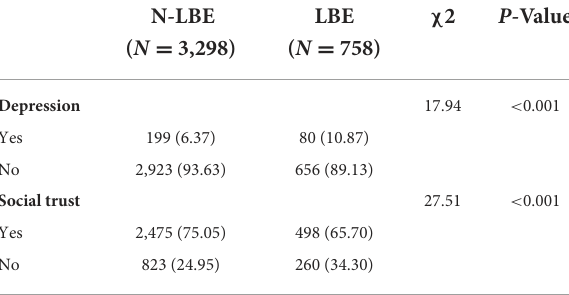
TABLE 2 Depression and social trust by left-behind experience status, N (%).